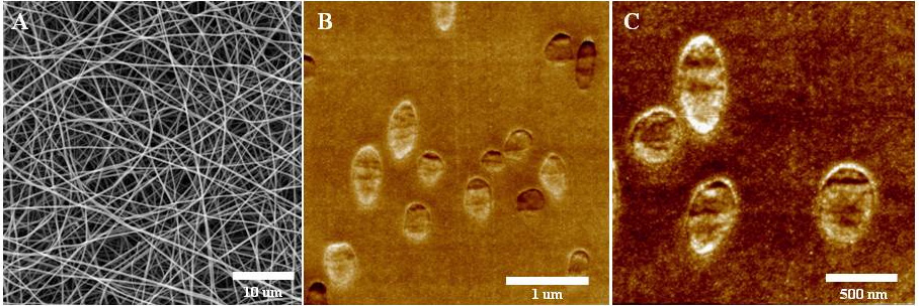
Figure 1. Structure of MS-RGD scaffolds: ( A )—SEM image, ( B , C )—SPM image. Images of MS scaffolds are not presented due to the absence of significant structural differences.